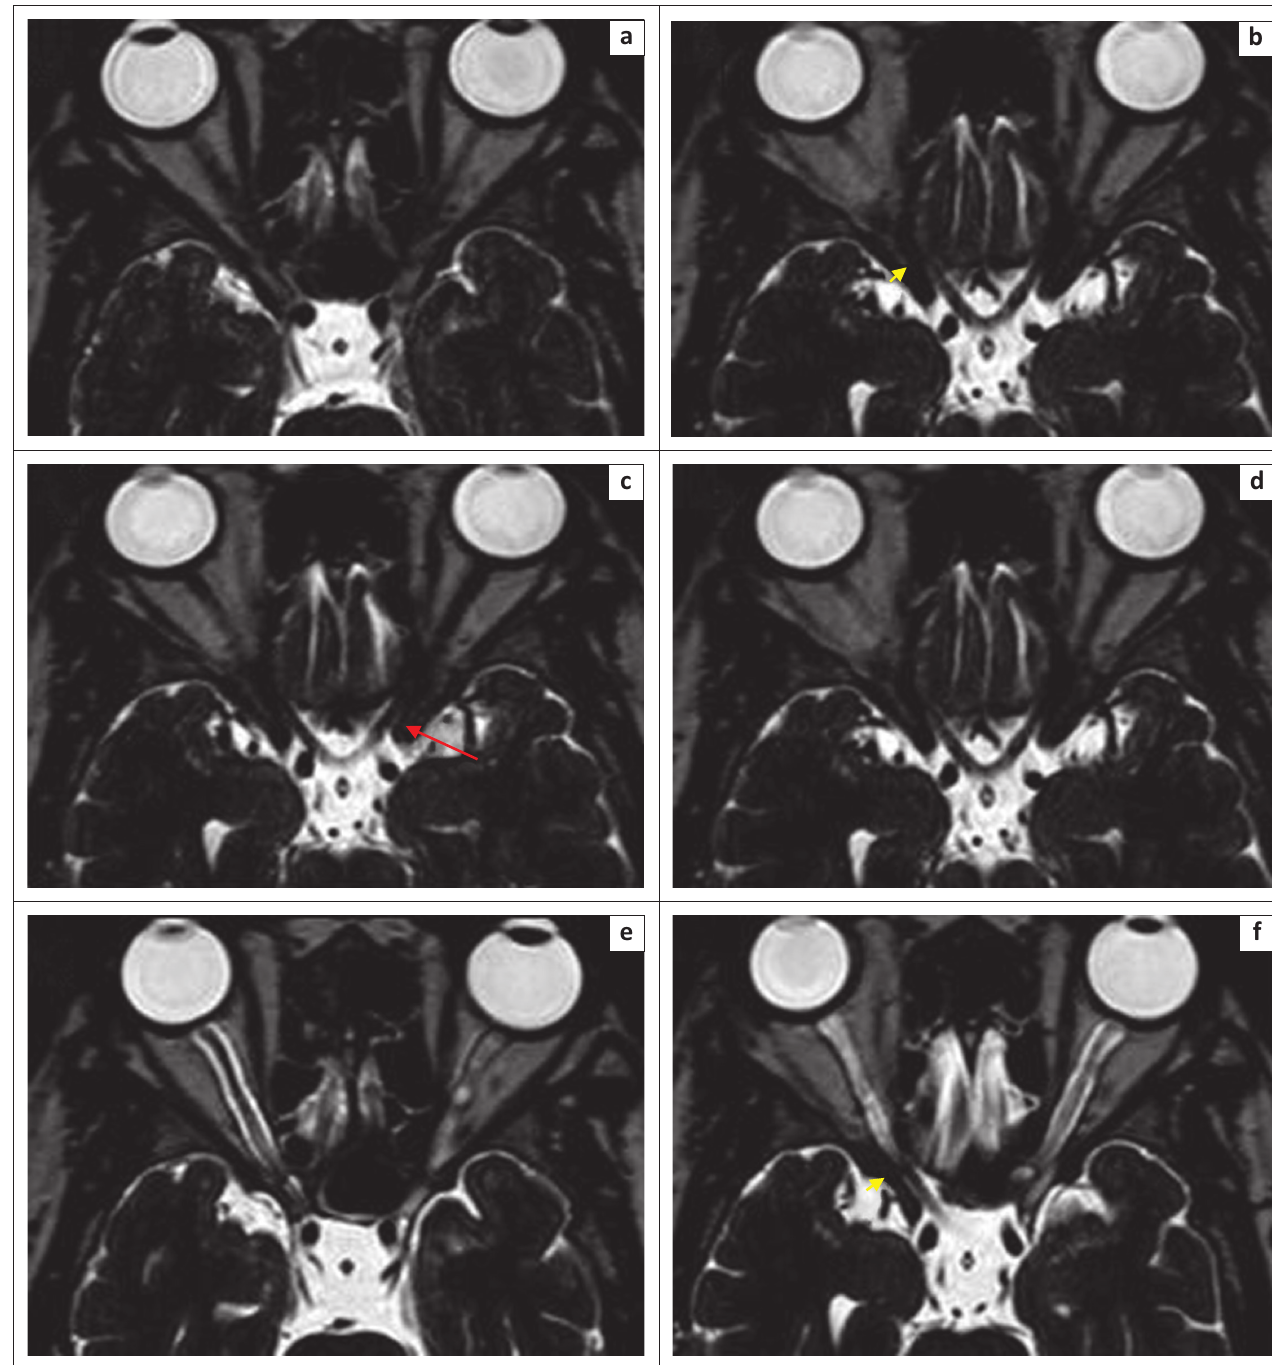
FIGURE 3: (a–h), Illustrative case of optic nerve sheath compartment